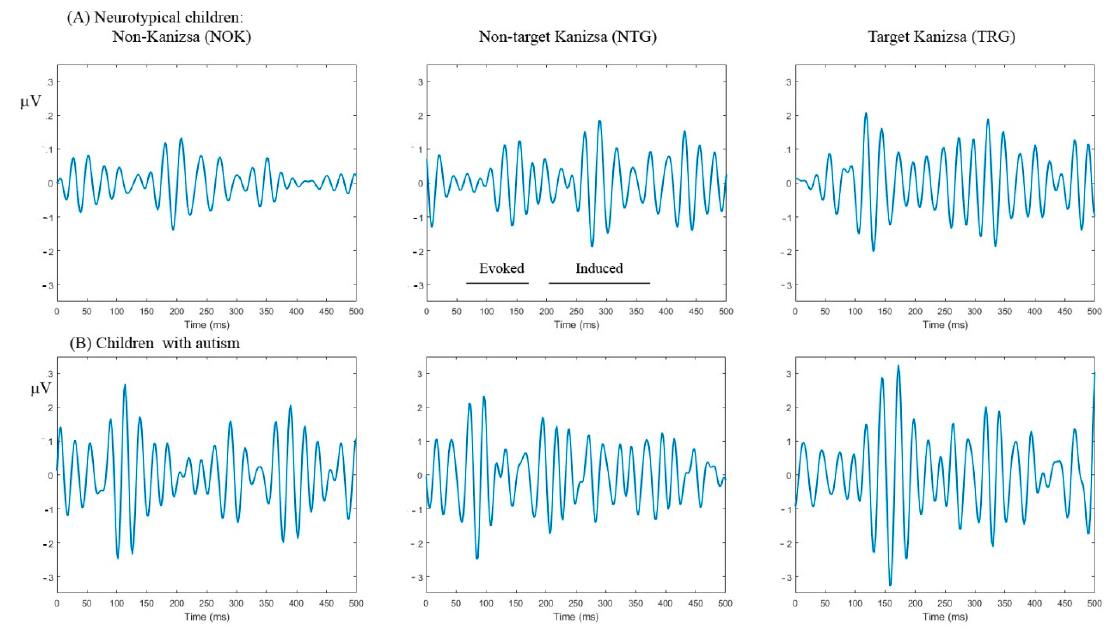
Figure 1. Evoked and induced gamma oscillation waveforms in response to target Kanizsa, non-target Kanizsa, and non-Kanizsa stimuli in neurotypical children ( A ) and children with autism spectrum disorder (ASD) ( B ). Both evoked and induced gamma oscillations have higher magnitude in the ASD group at the frontal sites (F3, F4). Table 1. Evoked and induced gamma oscillations positive and negative areas in response to rare target Kanizsa (Target), rare non-target Kanizsa (Non-target) and frequent non-Kanizsa standard (Non-Kanizsa) stimuli at the frontal and parietal electroencephalogram (EEG) sites in 19 children with autism (ASD) and in neurotypicals (CNT). Means ± SD. * p < 0.05; ** p < 0.001; *** p <